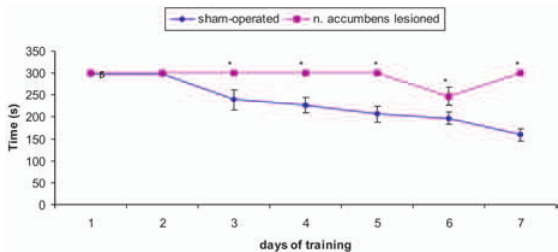
Figure 3. Cell cytotoxicity after exposure of the HUVEC cultures to distilled water (a) respective conditioned water with biomaterial E1 (b), E4 (c) and E5 (d) for 24 and 72 hours (results are shown as % of untreated controls). Panels are representative of three independent experiments; p ≤ 0.05 was considered significant.